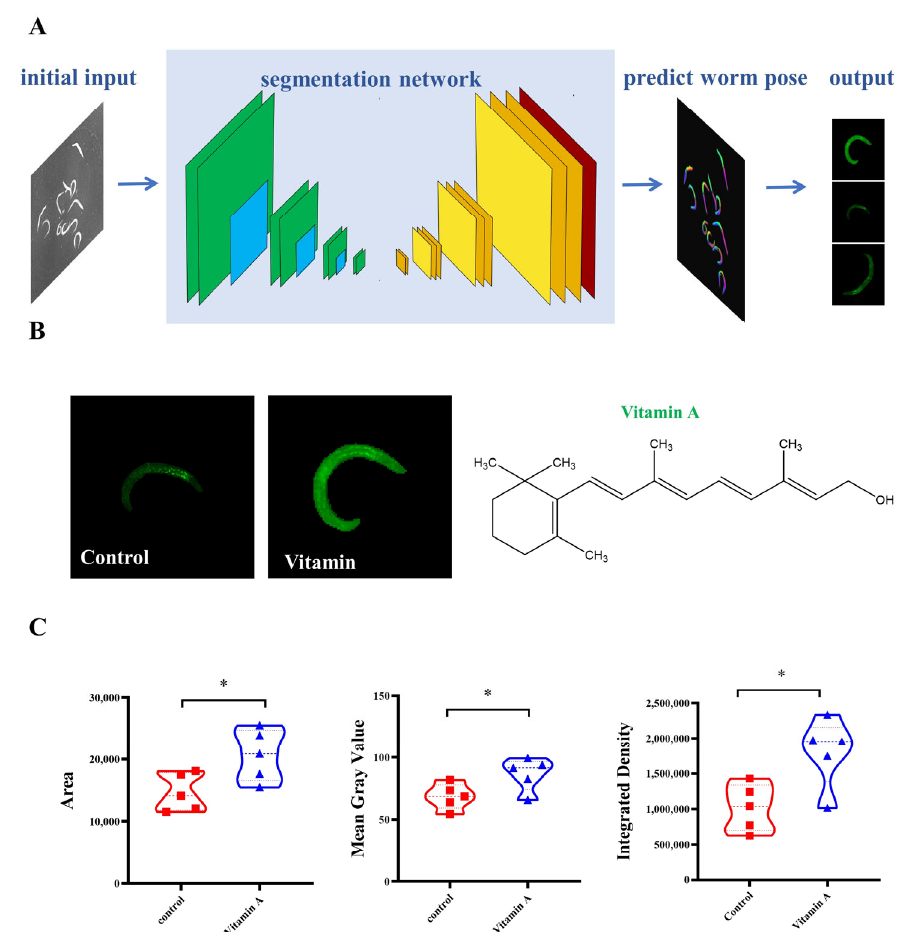
Figure 3. Single nematode cutting method for Scellsegs software ( A ) Software for single nematode isolation process; ( B ) Single nematode images obtained from the Control and vitamin A groups; ( C ) Analysis of single nematode related data for Control and Vitamin A groups (* p < 0.05 for the designated treatment vs. Control), n = 5.